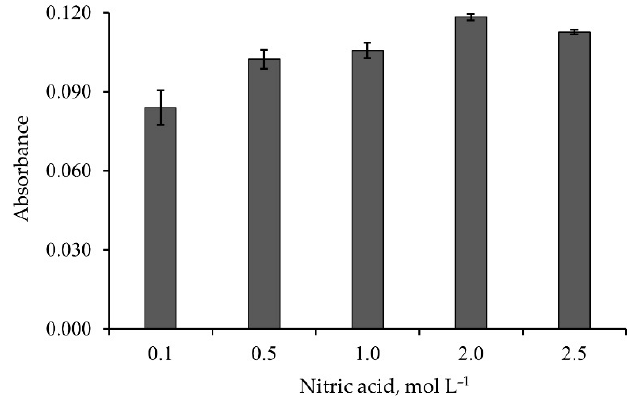
Figure 3. Effect of nitric acid concentration on elution of the loaded Pb 2+ .